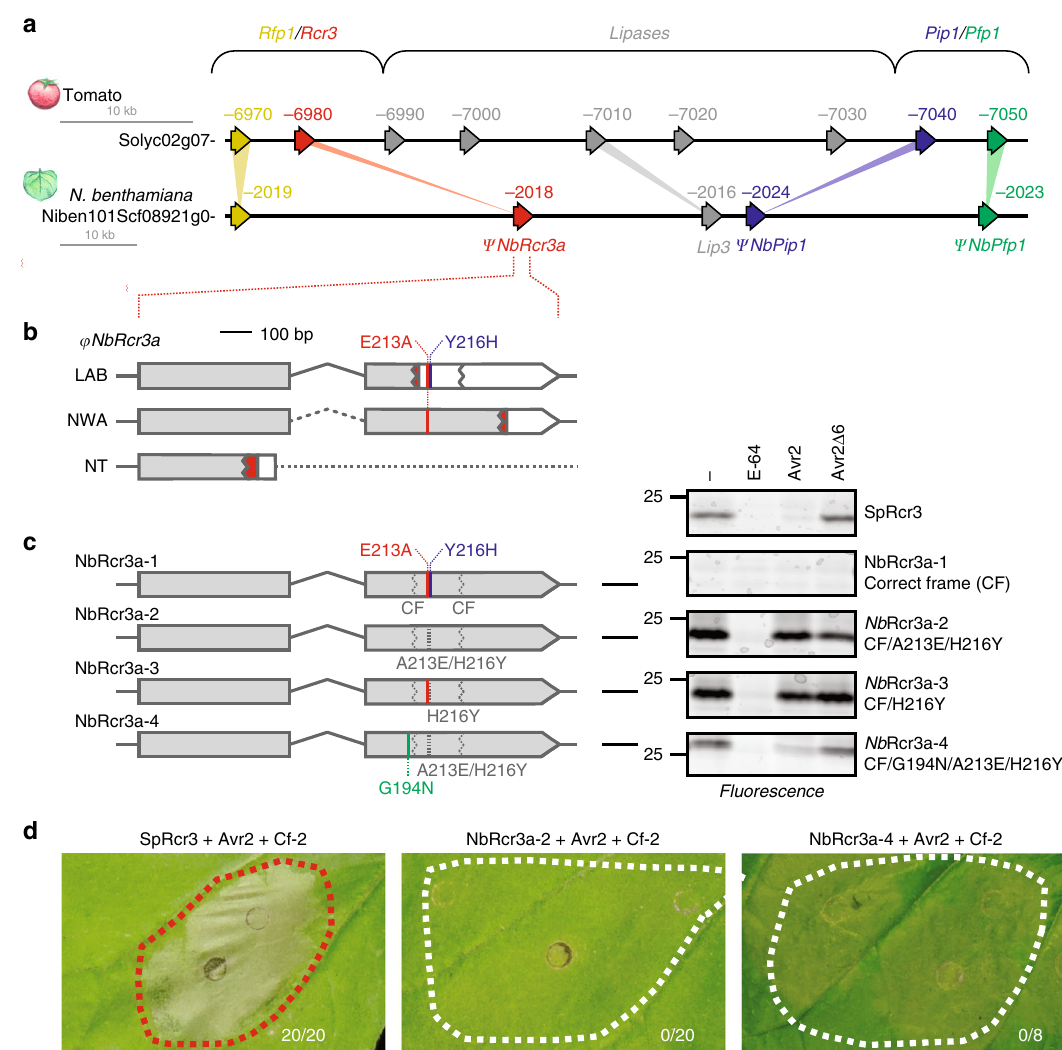
Fig. 2 Resurrection of NbRcr3 a null mutant establishes activity and Avr2 inhibition but not HR. a Synteny between tomato and N. benthamiana Rcr3 / Pip1 loci. b Schematic representation of mutations in NbRcr3a in different N. benthamiana accessions. Dotted line indicates unknown sequence; dashed line indicates presumed intron sequence; red indicates a different ORF after indels, white indicates the untranslated region overlapping with the Rcr3 ORF in a different frame. Two additional SNPs causing E213A and Y216H substitutions are indicated in red and blue, respectively. c Resurrection of Nb Rcr3a activity and Avr2 inhibition. Tomato Sp Rcr3 and Nb Rcr3a mutants 1 – 4 (left) were produced by agroin fi ltration of N. benthamiana leaves. Apoplastic fl uids were isolated at 2 dpi and preincubated for 45 min with and without 100 µ M E-64, 2 µ M Avr2 or Avr2 Δ 6, and labelled for 3 h with 2 µ M MV201. Samples were separated on SDS-PAGE gels and scanned for fl uorescence. d Transient co-expression of resurrected Nb Rcr3a-2 or -4 with Cf-2 and Avr2 does not trigger a HR in N. benthamiana . Pictures were taken at 5 dpi. Numbers indicate the number of leaves showing